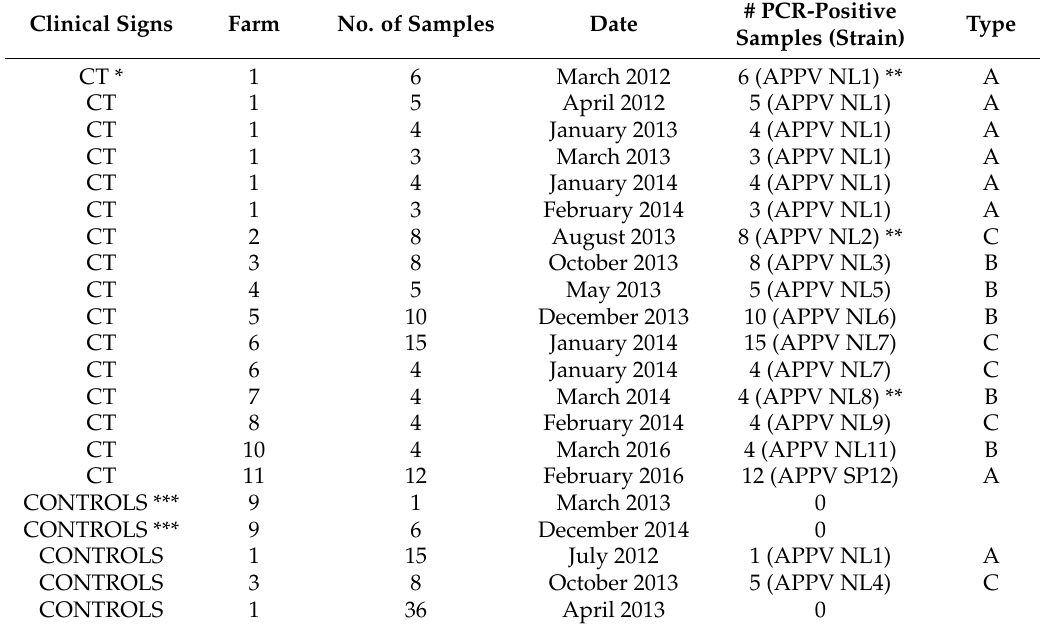
Table 1. Presence and distribution of atypical porcine pestivirus (APPV)